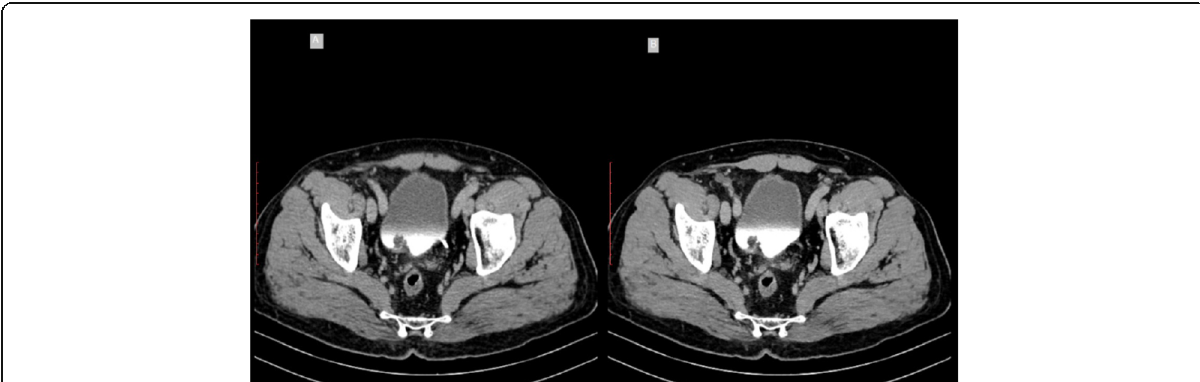
Fig. 1 Male patient, 68 years old, 98 kg. a Axial CT urogram obtained during excretory phase demonstrate CT urography standard dose with FBP protocol A2, SNR were 4.25 and 2.88 at aorta and psoas muscle, respectively. CNR were 11.68 and 10.45 at aorta and psoas respectively. b Axial CT urogram with low dose with IR protocol B2, SNR were 4.55 and 2.91 at aorta and psoas respectively. CNR were 13.46 and 12.02 at aorta and psoas, respectively. Both protocols showing bladder mass